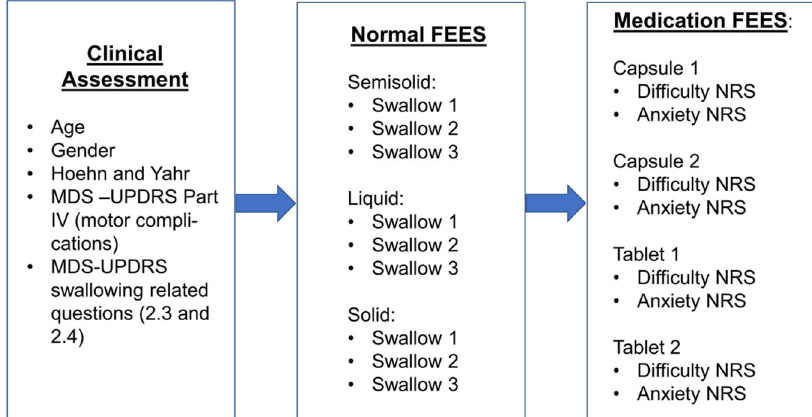
Fig. 3 Illustration of the study design. FEES Flexible Endoscopic Evaluation of Swallowing, MDS-UPDRS Movement Disorder Society- sponsored revision of the Uni fi ed Parkinson ’ s Disease Rating Scale, NRS Numeric Rating